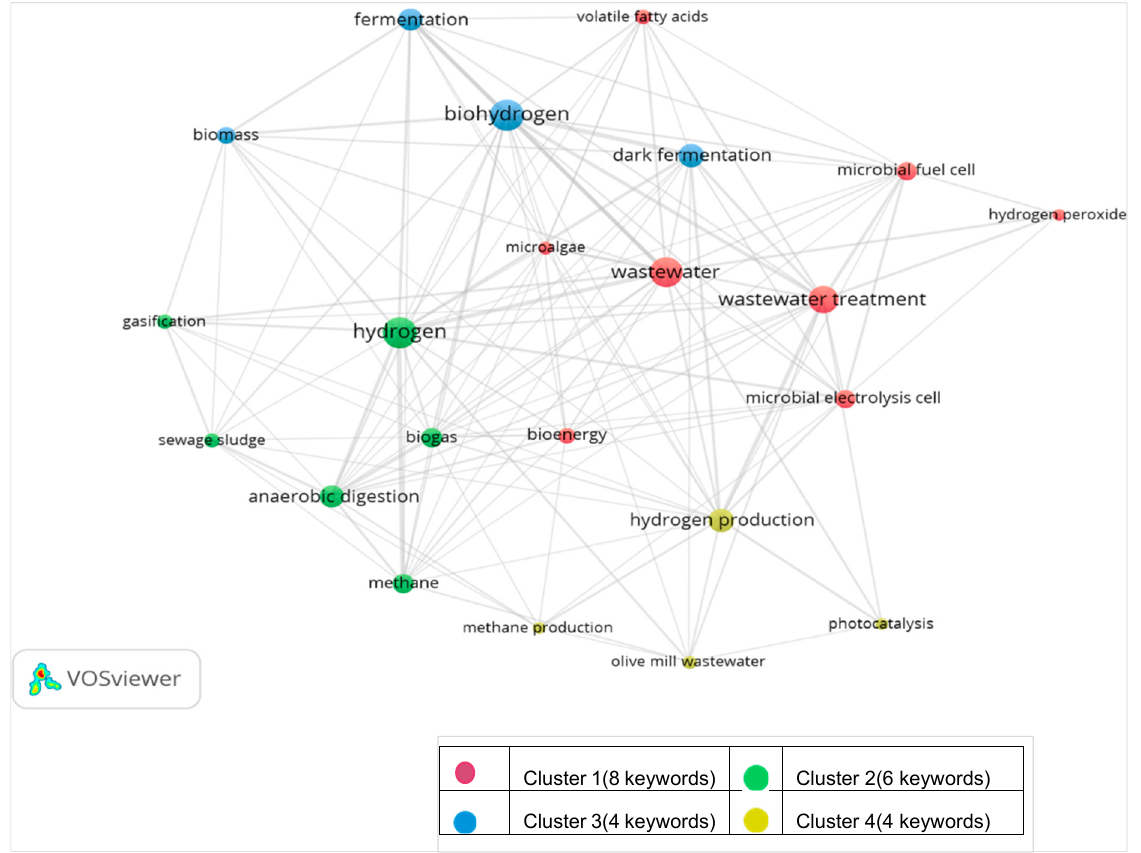
Figure 2. Cluster analysis of frequently used keywords based on associated strength.